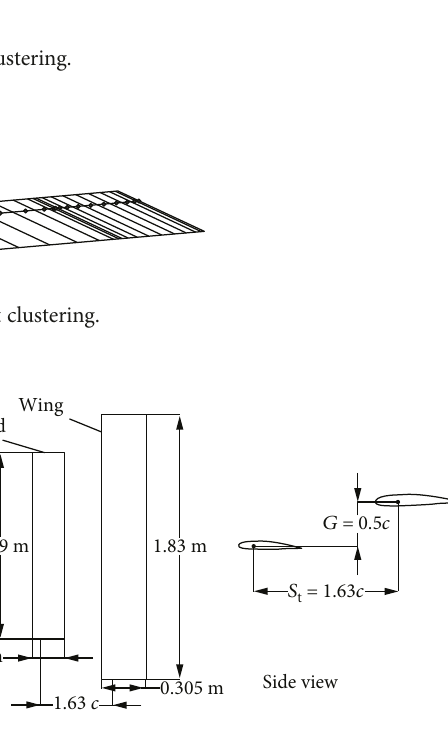
Figure 8: Wing-canard model top view and side